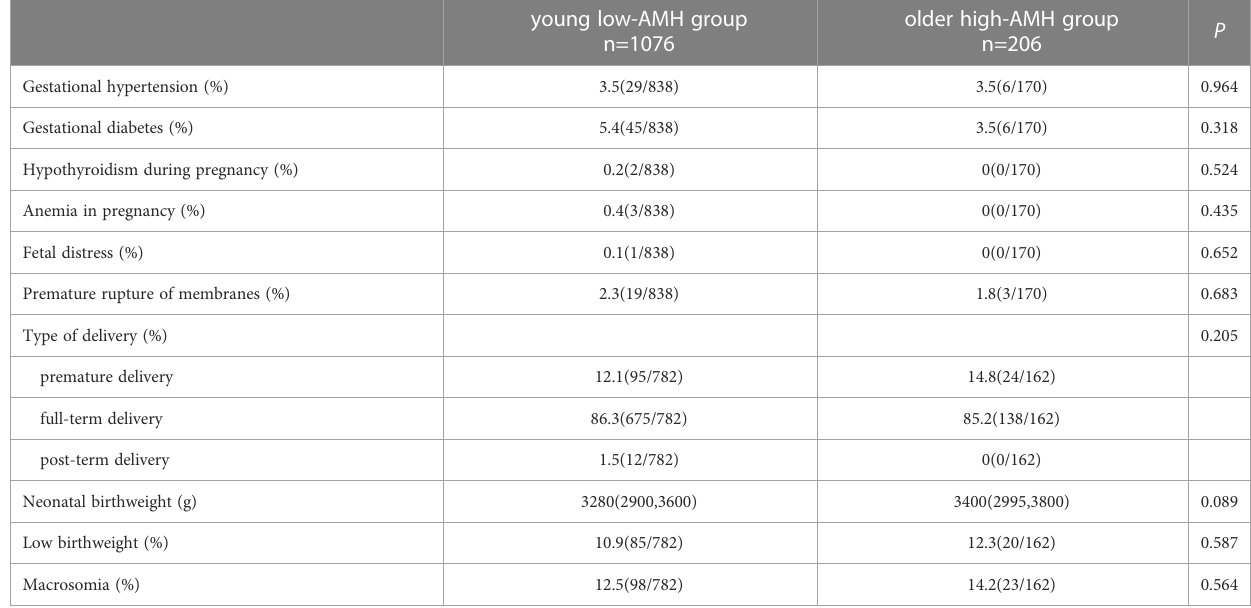
TABLE 3 Comparison of pregnancy complications and neonatal outcomes between the two groups.